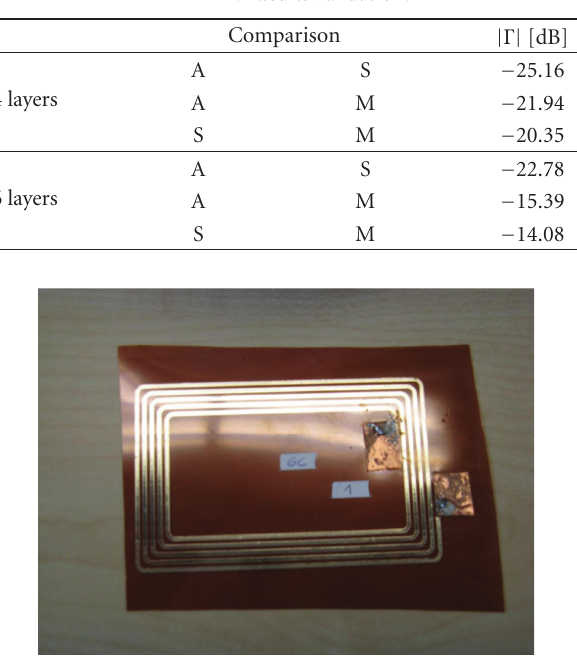
Figure 8: Printed prototype (6